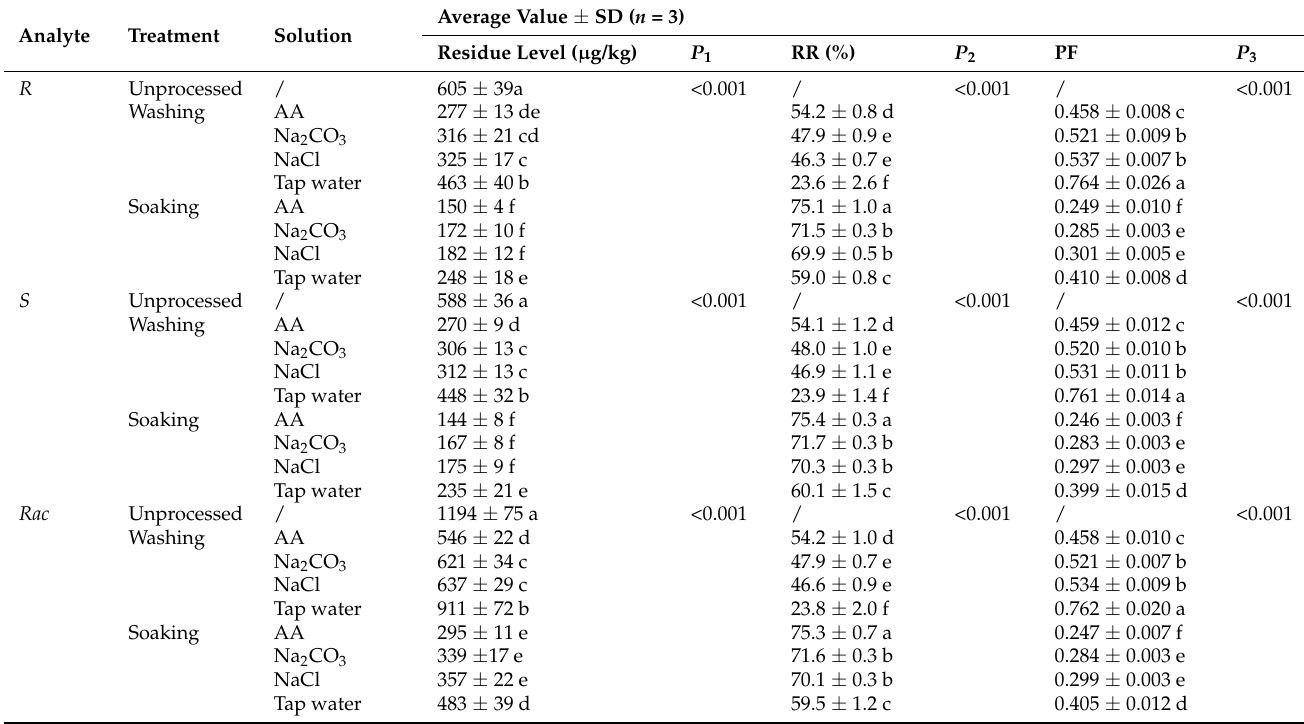
Table 2. Residue level, RR, and PF values of mandipropamid in unprocessed, washing and soaking cucumber samples.